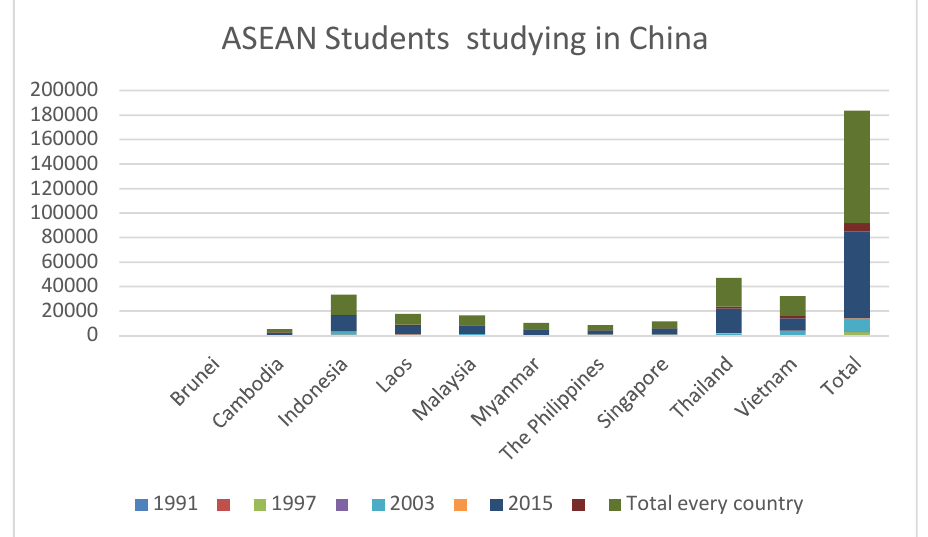
Figure 1. ASEAN Students studying in